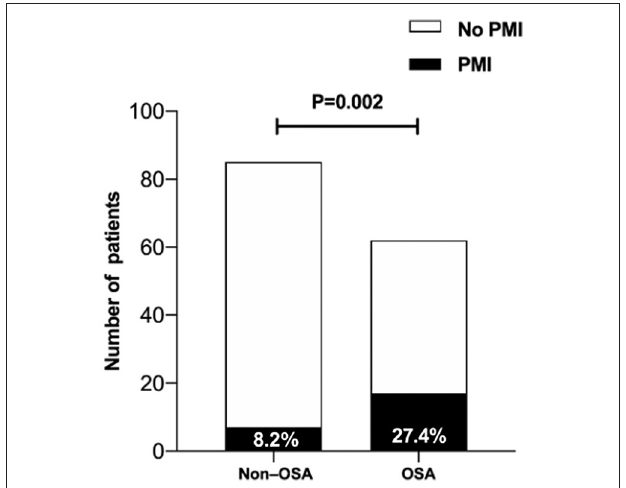
FIGURE 2 | The proportion of patients with PMI in the moderate-severe OSA group was significantly higher than in the non-OSA group. PMI, periprocedural myocardial infarction; OSA, obstructive sleep apnea.